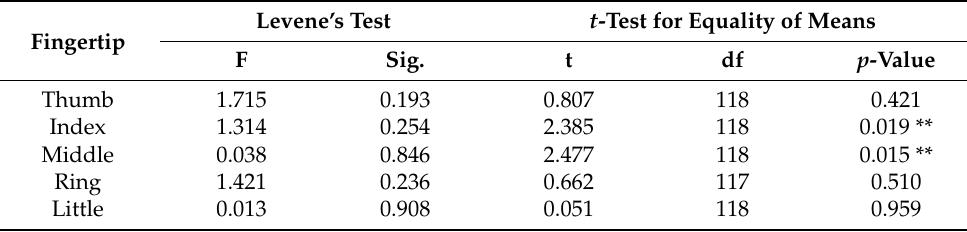
Table 8. Independent samples t -test for comparison finger forces in grasp subscale, with respect to different groups of age (18–32 years) and (45–72 years).